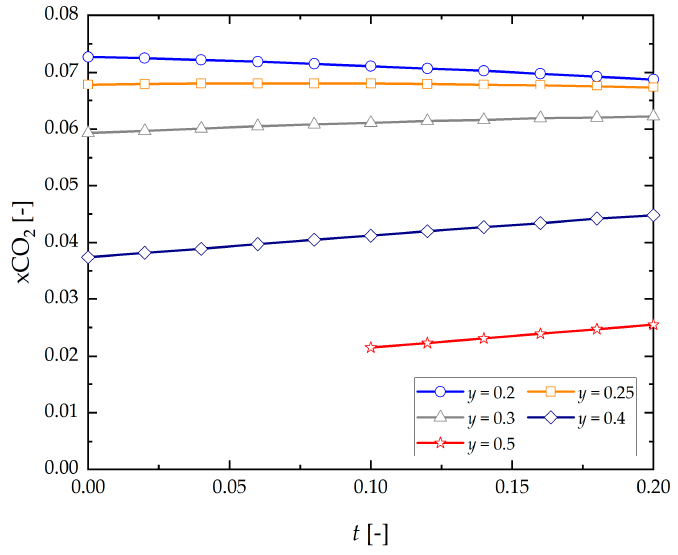
= f ( t , y ) with y = const, of the reforming process = 𝑓(𝑡, 𝑦) with y = const, of the reforming process (cid:3118) 2